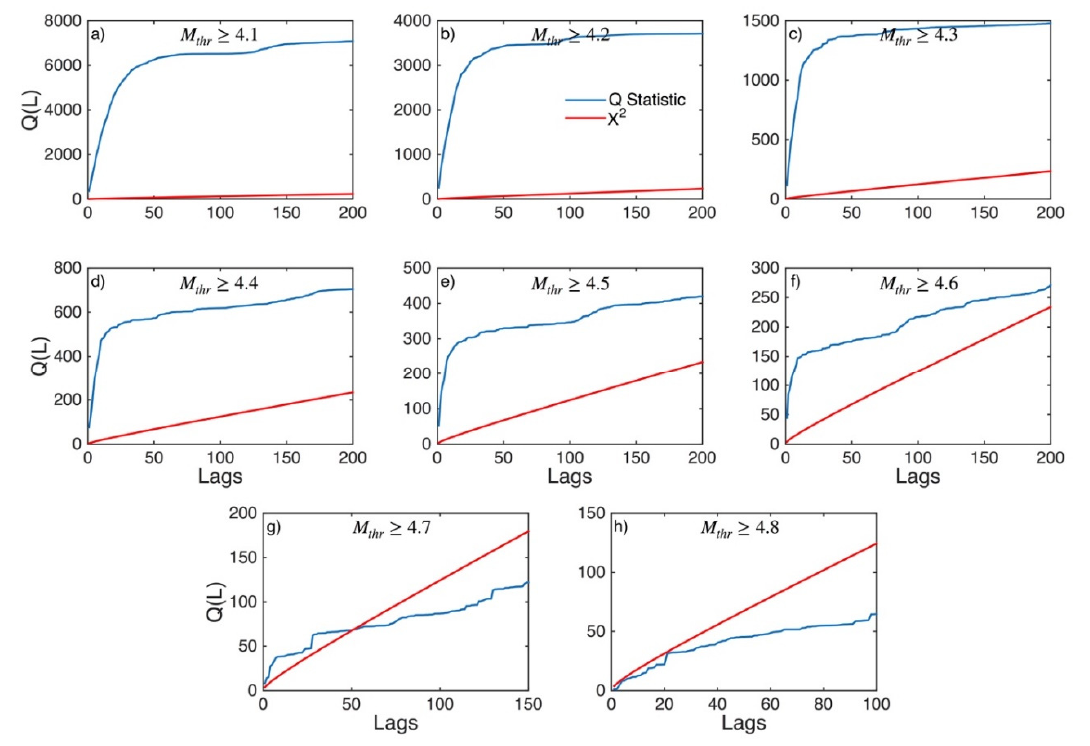
Figure A6. Statistics of Ljung–Box Q-test (blue lines) and the critical values for the X 2 distribution (red lines) for Western Hellenic Arc (sub-area 3) for magnitude thresholds ( M thr ) varying from 4.1 to 4.8 (subplots a – h ).